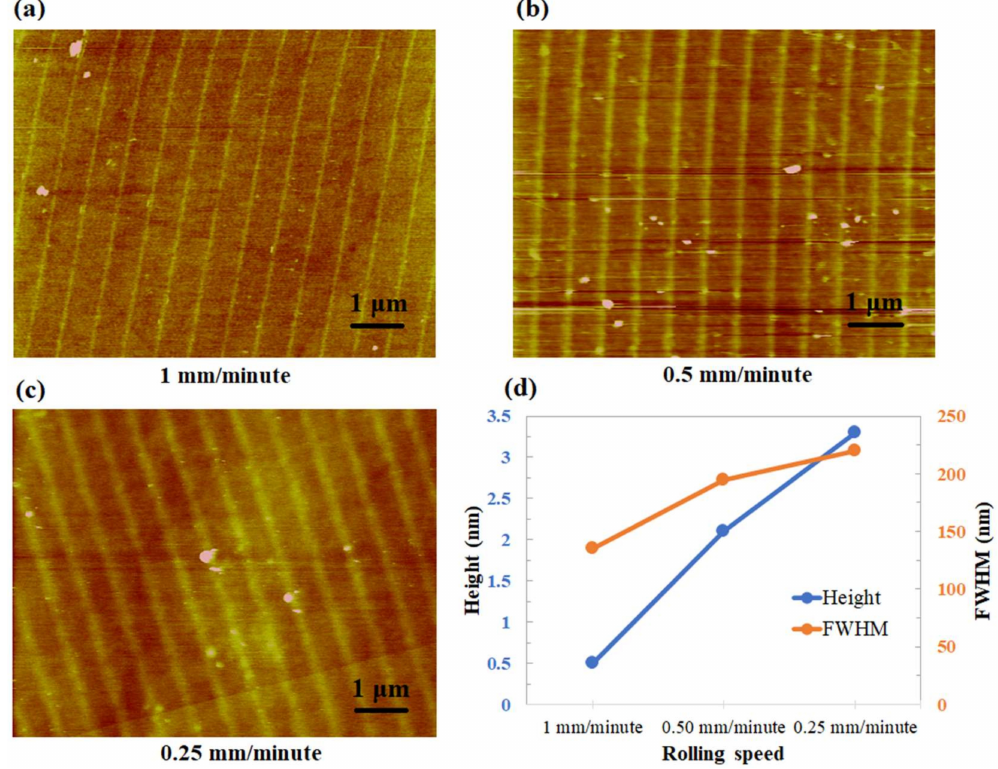
Figure 11. ( a – c ) AFM topographic images. ( d ) Relationship between the rolling speed and oxide height (left side of the graph) and full width at half maximum (FWHM) (right side of the